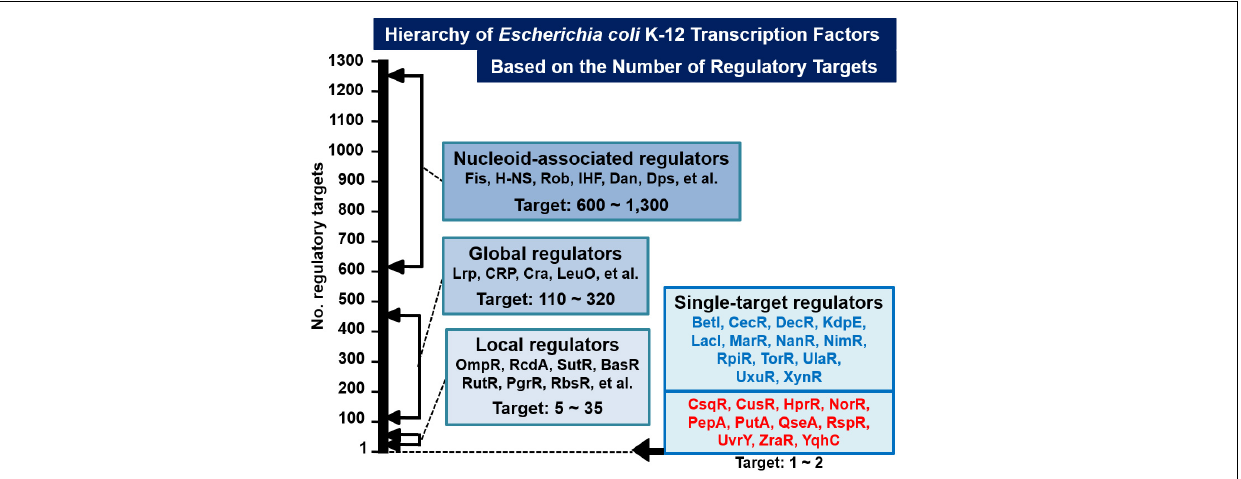
FIGURE 1 | Classification of TFs of Escherichia coli K-12 W3110. Based on the number of regulatory targets identified by gSELEX screening, approximately half of a total of about 300 E. coli K-12 TFs were classified into four groups (36; see also TEC database www.shigen.nig.ac/ecoli/tec/). Some representative TFs are shown in each group. In the case of nucleoid-associated regulators, the indicated number represents the total number of TF-binding sites on the E. coli K-12 genome. The first version of the list of single-target TFs (ST-TFs) includes 13 TFs (Shimada et al., 2018b) (indicated in blue). In this report, we described the second version of the list, including 11 additional ST-TFs (indicated in red).